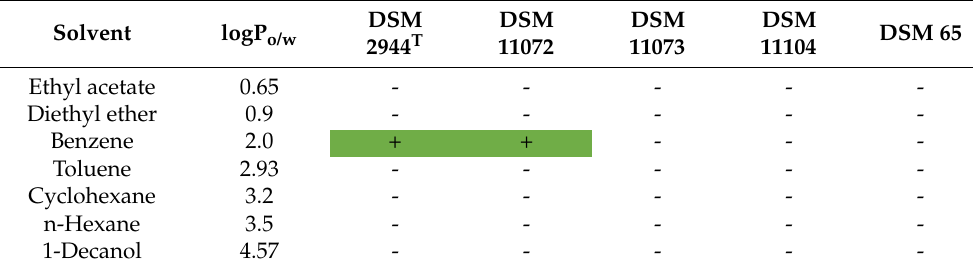
Table 9. Toxicity of different solvents. An LB medium was supplied with 5% ( v / v ) of the respective solvent. Cultures were incubated for up to three days in airtight serum flasks, during which changes in OD600 were measured. Rising OD determined growth. DSM Solvent logP o/w 2944 T Diethyl ether Benzene